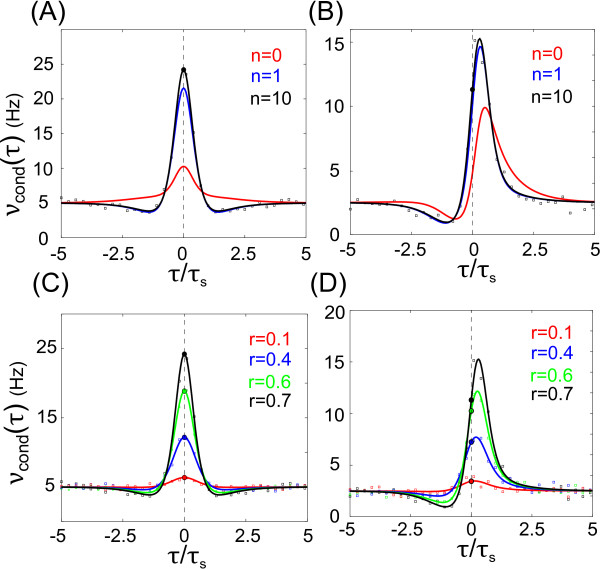
Convergence of pairwise level crossing correlations. a Spike correlation function νcond(τ) vs. time lag τ for different truncation orders n in Eq. (17); r=0.7, σV1=σV2=10 mV, τs=20 ms, ν=5 Hz, ψ=9.64 mV. bνcond(τ) vs. τ for a pair of rate heterogeneous neurons with r=0.7, σV1=10 mV, σV2=5 mV, τs=20 ms, ν1=5 Hz, ν2=1.24 Hz, ψ=9.64 mV. cνcond(τ) vs. time lag for varying correlation strengths r in a pair of neurons with σV1=σV2=10 mV, τs=20 ms, ν=5 Hz, ψ=9.64. dνcond(τ) vs. time lag for varying correlation strengths r, in a pair of rate heterogeneous neurons with σV1=10 mV, σV2=5 mV, τs=20 ms, ν1=5 Hz, ν2=1.24 Hz, ψ=9.64. The truncation order of νcond(τ)-series in Eq. (17) in c–d is n=10. In a–dthe filled circles at τ=0 indicate the predicted νcond(0) (as in Eq. (23)) and colored squares denote the corresponding numerical simulations obtained with N=2000 independent realizations of 20 s length